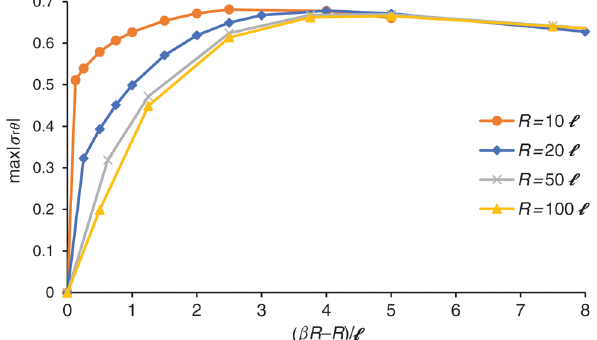
(solid curve) on the x -axis when b r θ /( π ( κ + x